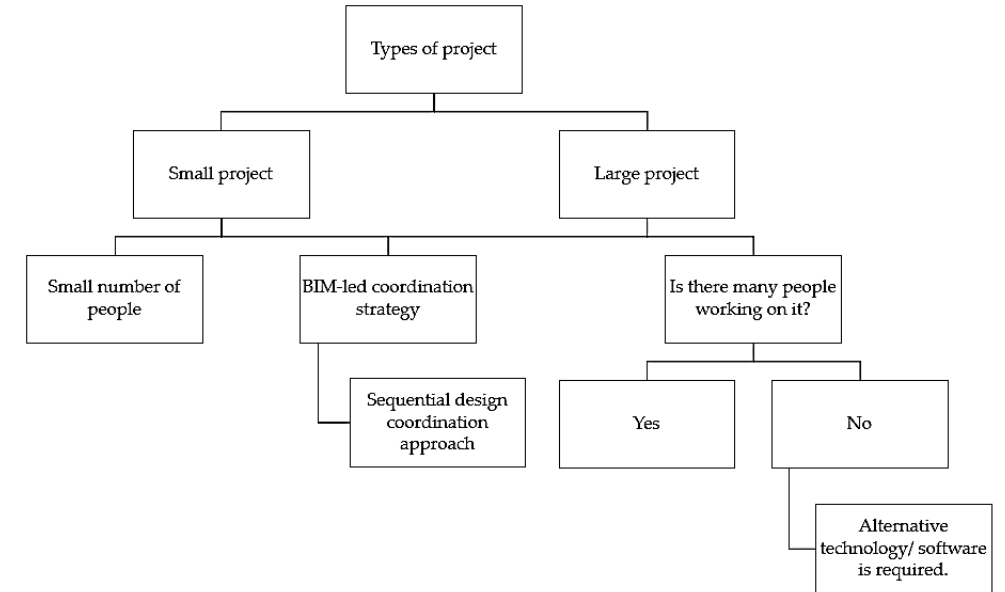
Figure 5. A summary of management strategies recommended for small and large projects. The similarity between small and large projects is that both are suitable for using a BIM-led coordination strategy [30] and sequential design coordination approach [64]. Alternative technology/software in BIM is required when there is a limited number of people working on a large project.